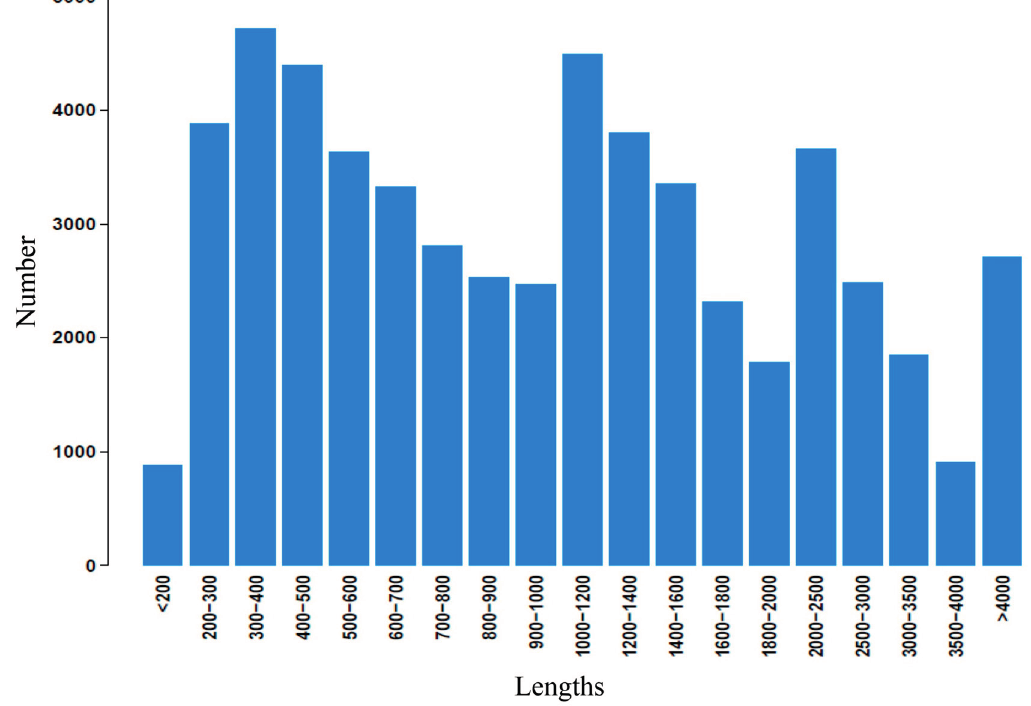
Figure 2. Length distribution of assembled